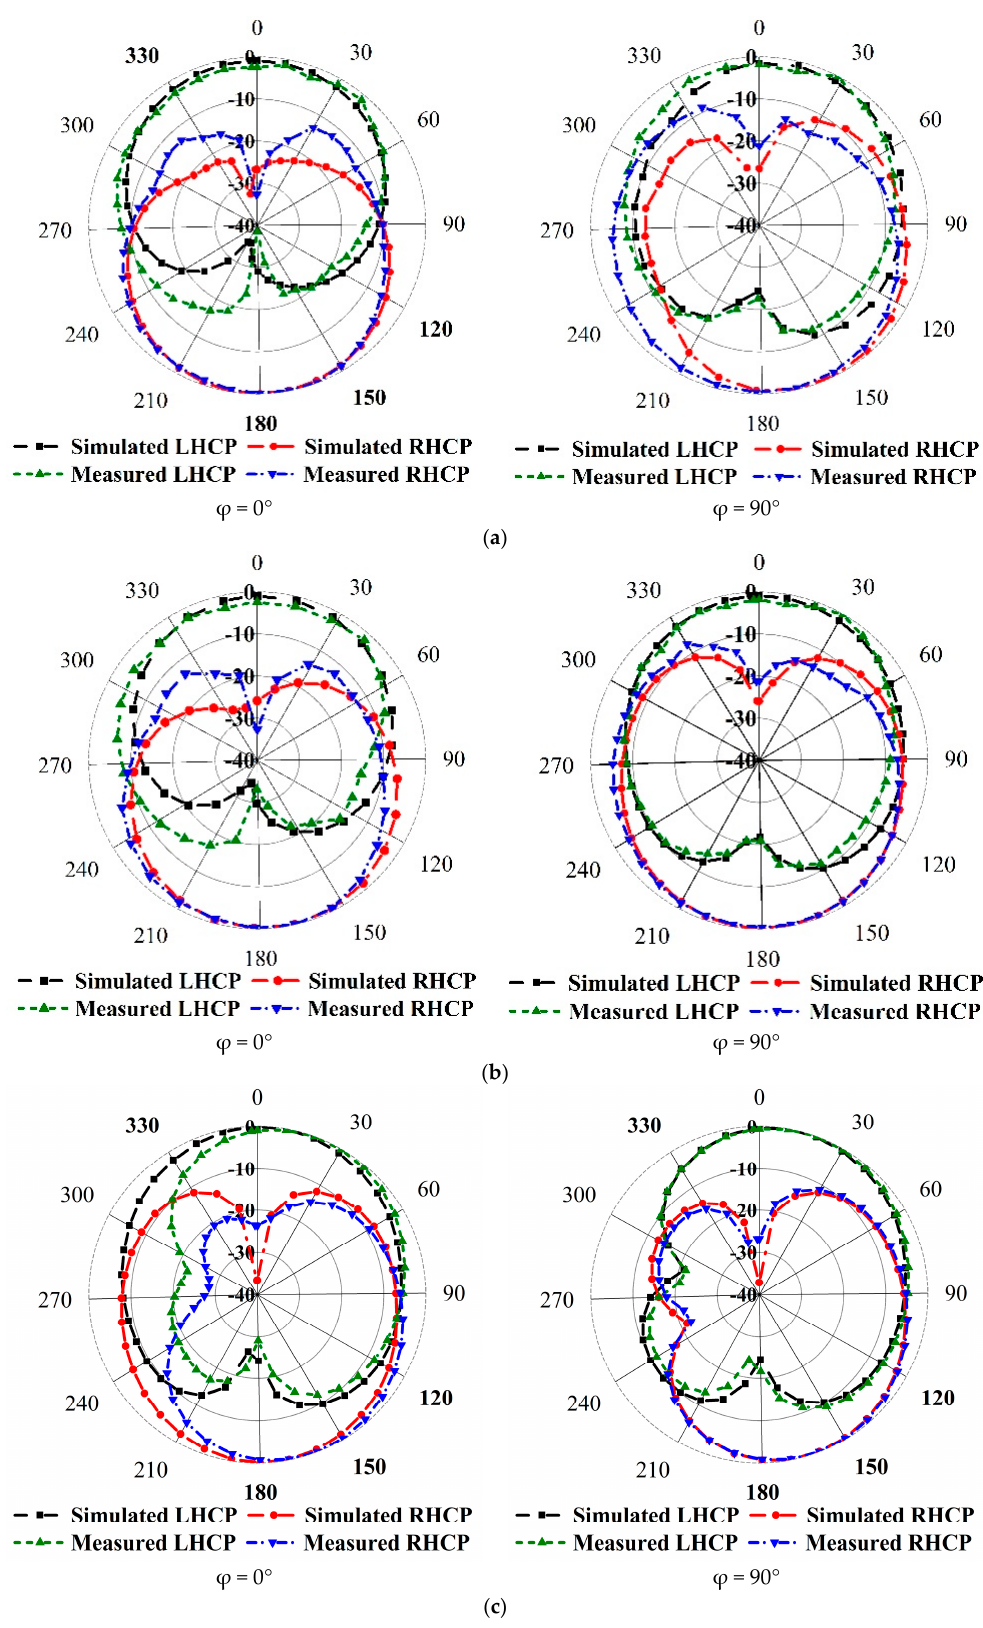
Figure 7. The numerical and measured CP radiation patterns at ( a ) 2.4 GHz (LHCP and RHCP) ( b ) 3.5 GHz (LHCP and RHCP) and ( c ) 4.3 GHz (LHCP and